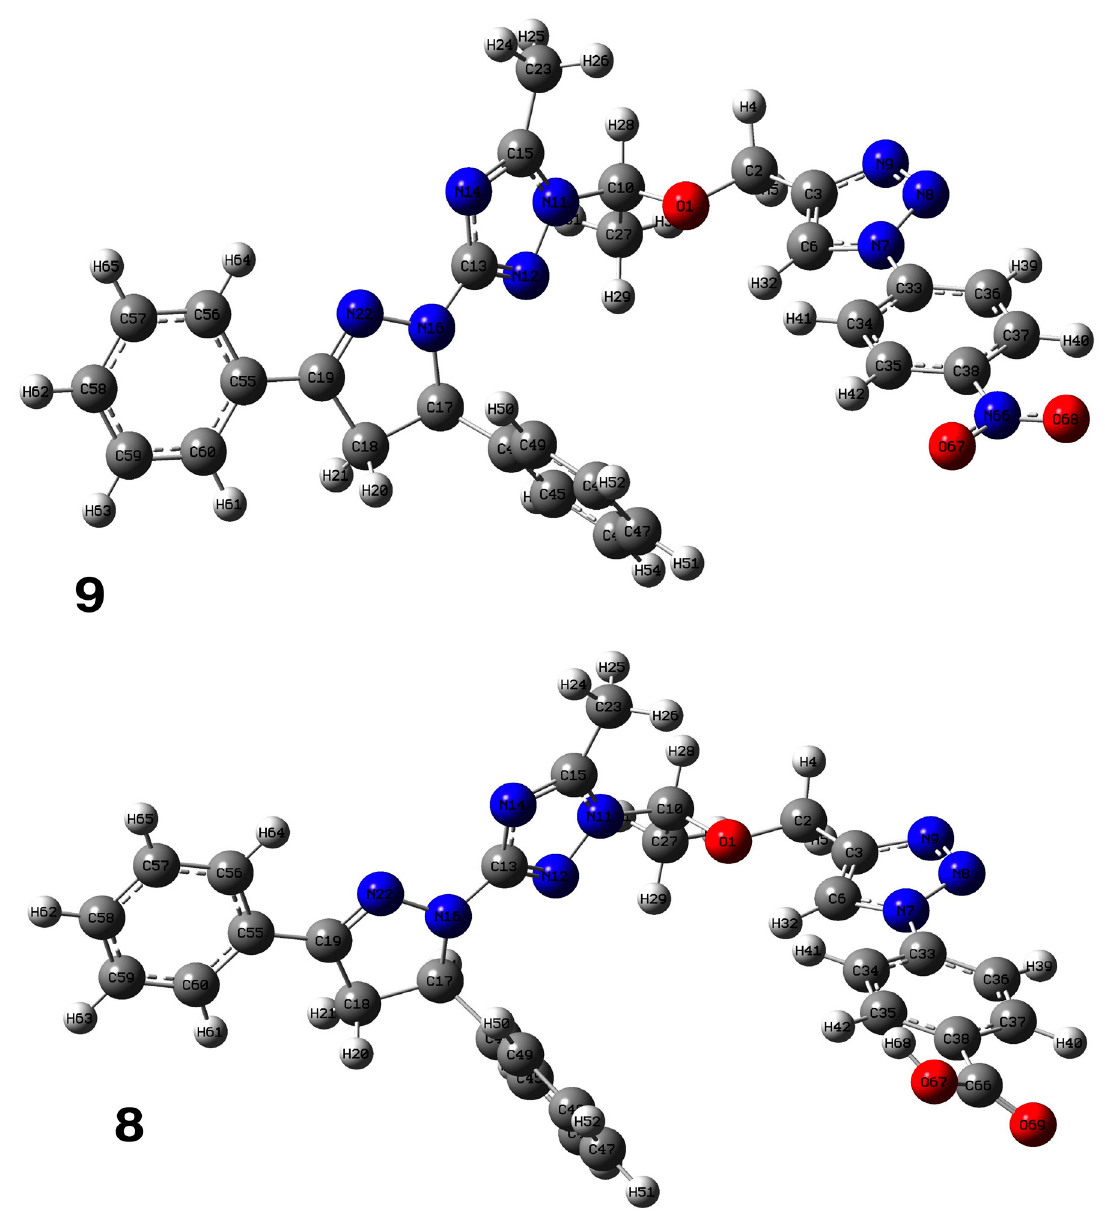
Figure 2. Optimized structure of 8 and 9 derivatives at the B3LYP/6-311++G(d,p) level of theory in the gas phase. The biological activities of molecules, such as antitumor, anticancer, and antioxidant activities, depend on the facile electron/proton transfer process. For example, the ease of the oxidation process largely depends on electron excitation and transition within biological active molecules. Hence, simulated UV-Vis spectra in the gas phase and in H 2 O were analyzed. In order to simulate the absorption spectrum of ( 4 – 9 ) derivatives, time-dependent density functional theory (TD-DFT) calculations based on the optimized structures at the B3LYP/6-311++G(d,p) level of theory were performed individually in the gas phase and in aqueous medium [28]. The calculated HOMO and LUMO orbitals of the triazole derivatives ( 4 – 9 ), are presented in Table 1, while the calculated HOMO and LUMO energies and the corresponding energy gap are shown in Table 2. An analysis of the data revealed that both the HOMO and LUMO orbitals are situated on pyrazole moieties in 5 , 7 , and 9